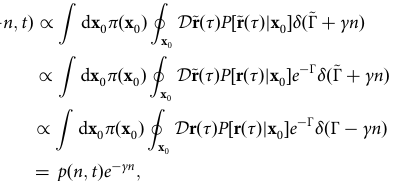
Fig. 4 Schematic of the lattice model used to derive Eq. (15). At each site ( x , y ) correspond four internal states A – D while internal and external transitions are, respectively, represented by gray and black arrows. The vectors e ∥ and e ⊥ de fi ne the orientation of the system ’ R H D r ð τ Þ P ½ r ð τ Þj x (cid:4) δ ð Γ (cid:3) γ n Þ , with normalizing constant as p ð n ; t Þ / d x 0 π ð x 0 Þ 0 x 0 π ( x 0 ) the distribution of initial positions x 0 . Using the same convention as in the main text that + n windings correspond to trajectories evolving forward in time, we thus write